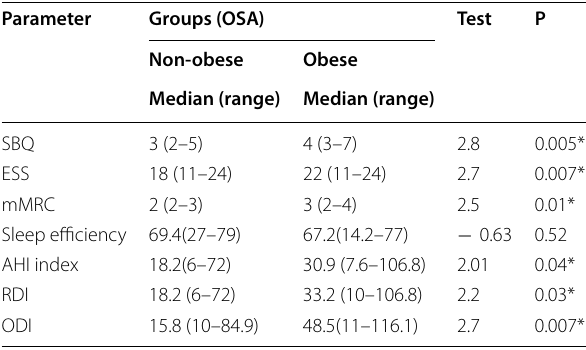
Table 5 Comparison of Questionnaires data and